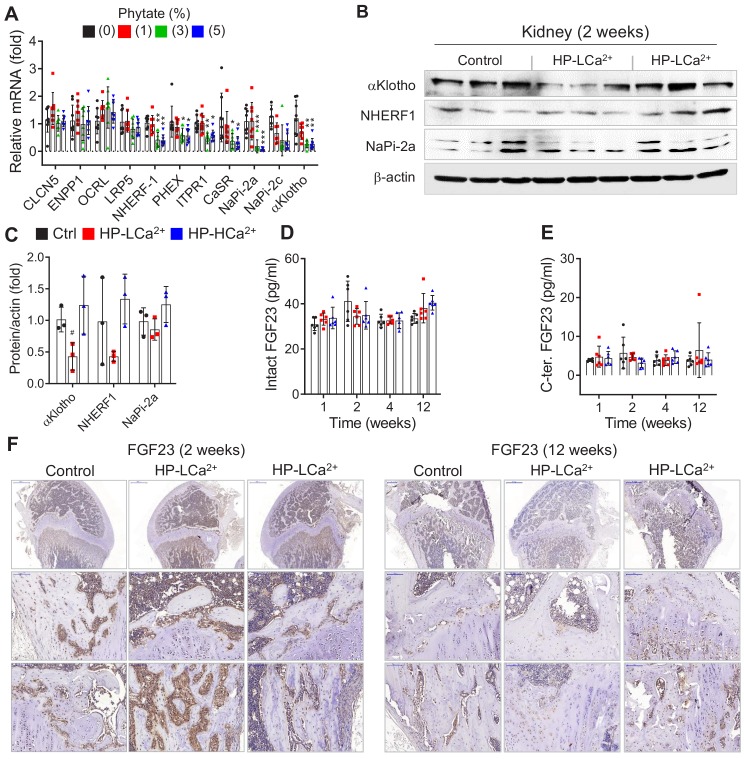
High phytate-induced renal phosphate wasting is independent of FGF23.(A) The renal expression of downregulated genes associated with Ca2+ and phosphate homeostasis in rats fed control or phytate-supplemented diets (n = 8 per group). (B) Results of immunoblot analyses and protein levels of renal aKlotho, NHERF1, and NaPi-2a after 2 weeks for rats fed control, HP- LCa2+ , and HP-HCa2+ diets. (C) The levels of renal proteins were quantified using ImageJ software (n = 6 per group). (D, E) Time course analysis of serum levels of intact FGF23 (D) and C-terminal FGF23 (E) in rats fed control, HP-LCa2+ , and HP-HCa2+ diets. (F) Representative immunohistochemical staining of EDTA-decalcified femur sections for FGF23 from rats fed control, HP-LCa2+ , and HP-HCa2+ diets. All data are presented as the mean ± SD of each group (n = 3–8 per group). *, p<0.05; **, p<0.01; ***, p<0.001, compared with controls.